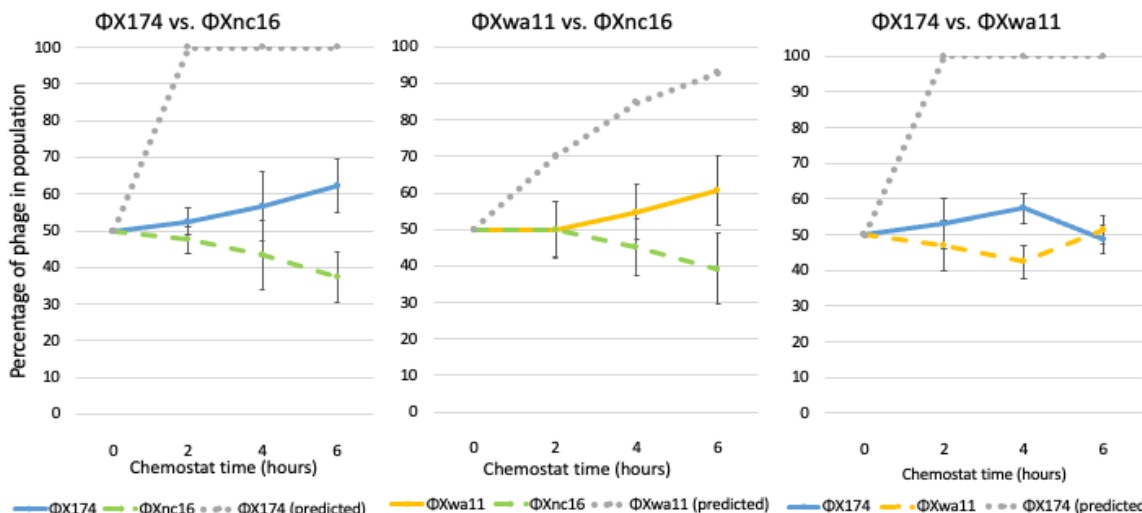
Figure 8. Population dynamics of ΦX174 and ΦX engineered phages in pair competitions over time. All chemostats were